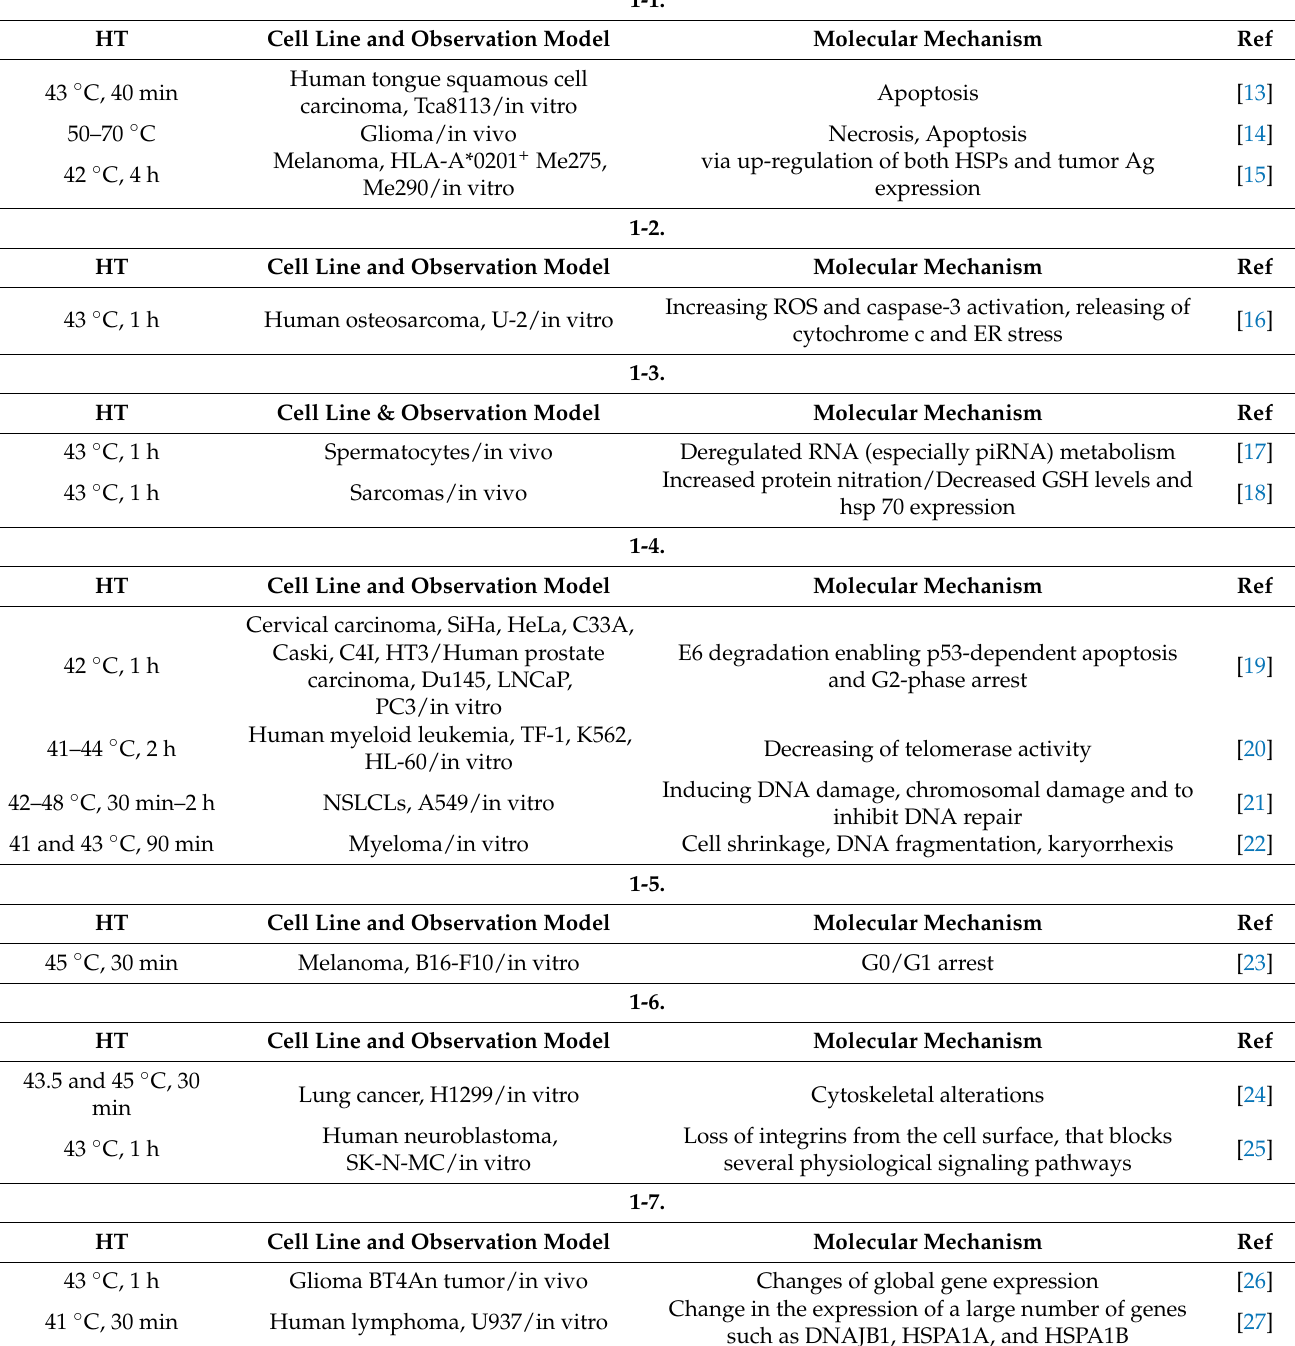
Table 1. 1-1. Effect of sole HT on tumor cells (unknown mechanism). 1-2. HT induces ROS production in tumor cells. 1-3. HT regulates HSPs in tumor cells. 1-4. HT induces DNA damage in tumor cells. 1-5. HT induces cell cycle arrest in tumor cells. 1-6. HT induces cytoskeletal alterations in